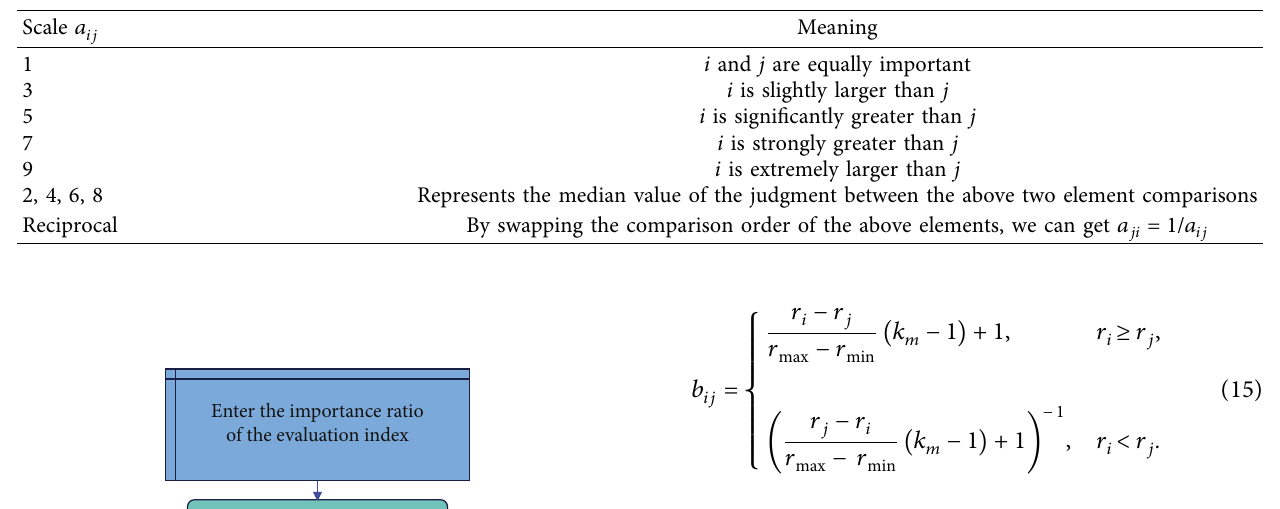
Table 1: Meaning of nine